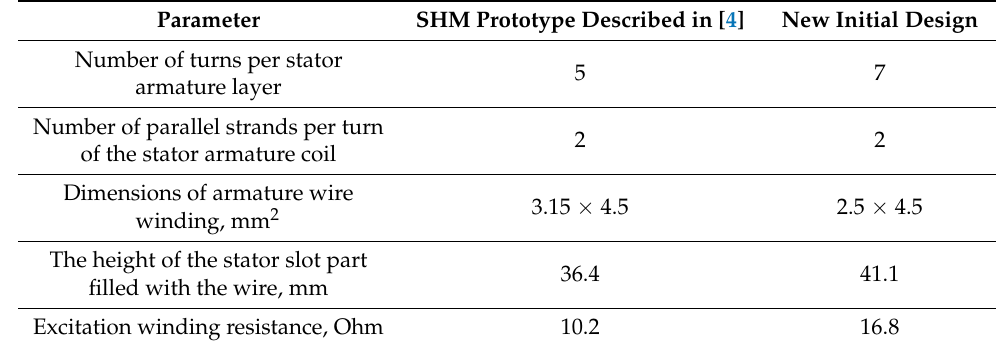
Table 4. Winding parameters that were non-varied during the optimization.